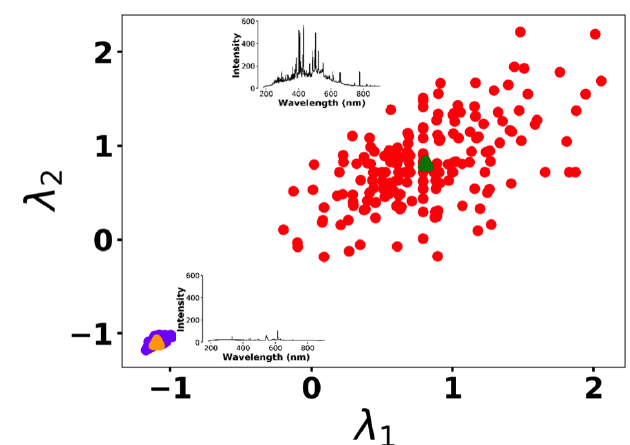
Figure 6. K -means clustering for detecting outliers before pass- ing the spectra set to the LASSO model. Two clusters were plotted for the normalized intensities of two arbitrary wavelengths at λ 1 (208.365nm) and λ 2 (208.759nm).